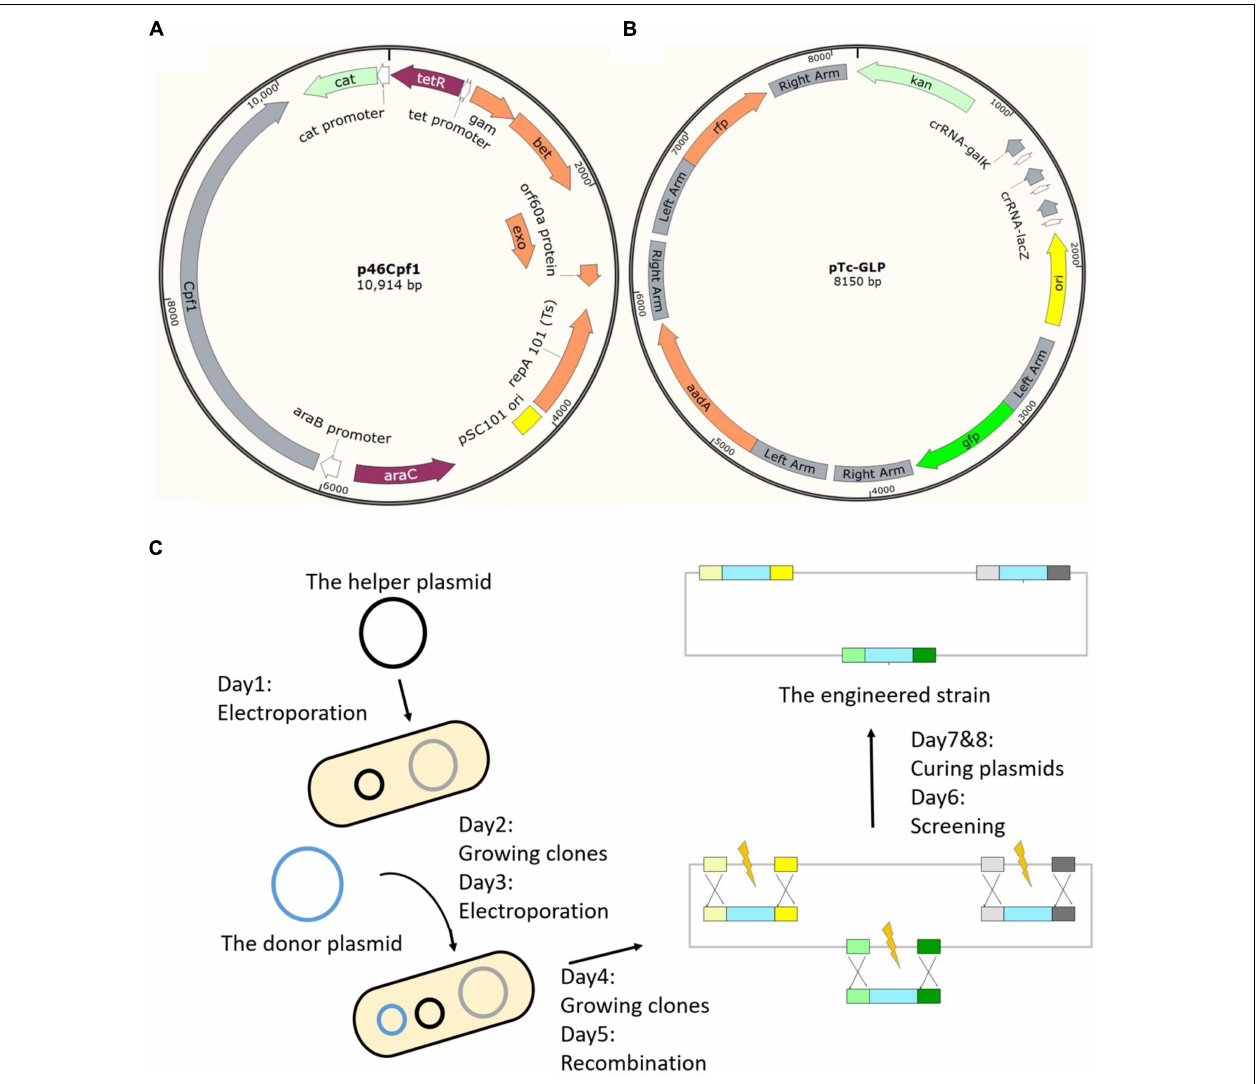
FIGURE 1 | Schematic maps of the developed method. (A) A schematic of the helper plasmid p46Cpf1, in which λ Red recombinases (Gam, Bet, and Exo) are expressed under the control of P tet , and Cas12a is expressed under the control of P araB . (B) A schematic of the donor plasmid pTc-GLP, which encodes crRNAs constitutively and provides the templates for recombination at three loci ( galK , lacZ, and pyrF ). (C) General outline of the multiplex gene insertion method. It takes 8 days to construct a modified plasmid-free